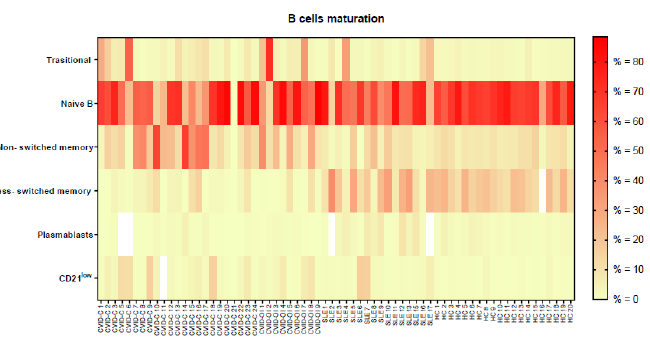
Figure 3. Differences in the proportions of B lymphocyte maturation between the CVID with complicated phenotype (CVID-C) group, CVID phenotype limited to only infections (CVID-OI